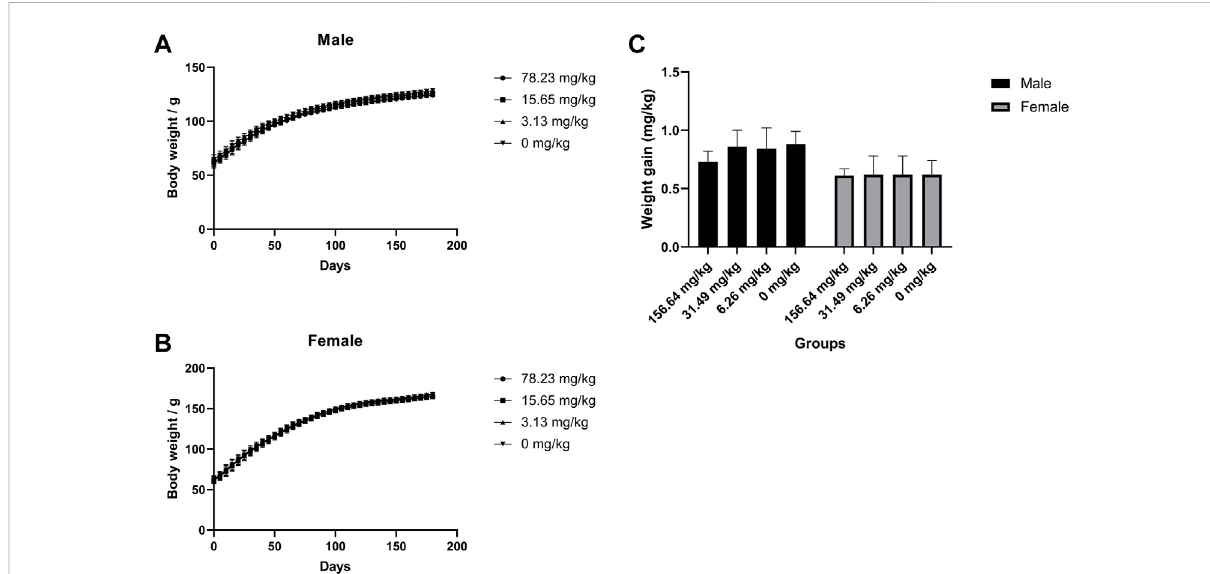
FIGURE 3 No effect of MCE on body weight gain in SD rats during 180 days of feeding. Male and female rats were orally administered 78.23, 15.65, 3.13, and 0 mg/kg ( n = 25 rats/gender). (A) Body weight of male rats at 180 days; (B) Body weight of female rats at 180 days; (C) Body weight gain of male and female rats for 180 days.